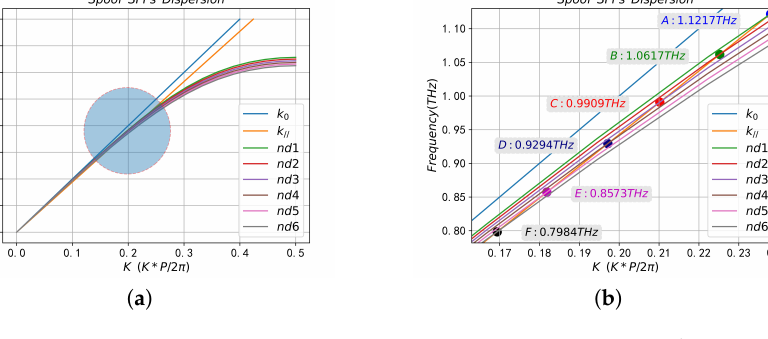
Figure 5. Dispersion curve corresponding to samples with di ff erent refractive indices ( a ), local magnification of dispersion curve in Figure 5a at SPR positions ( b ), SPR reflection spectrum ( c